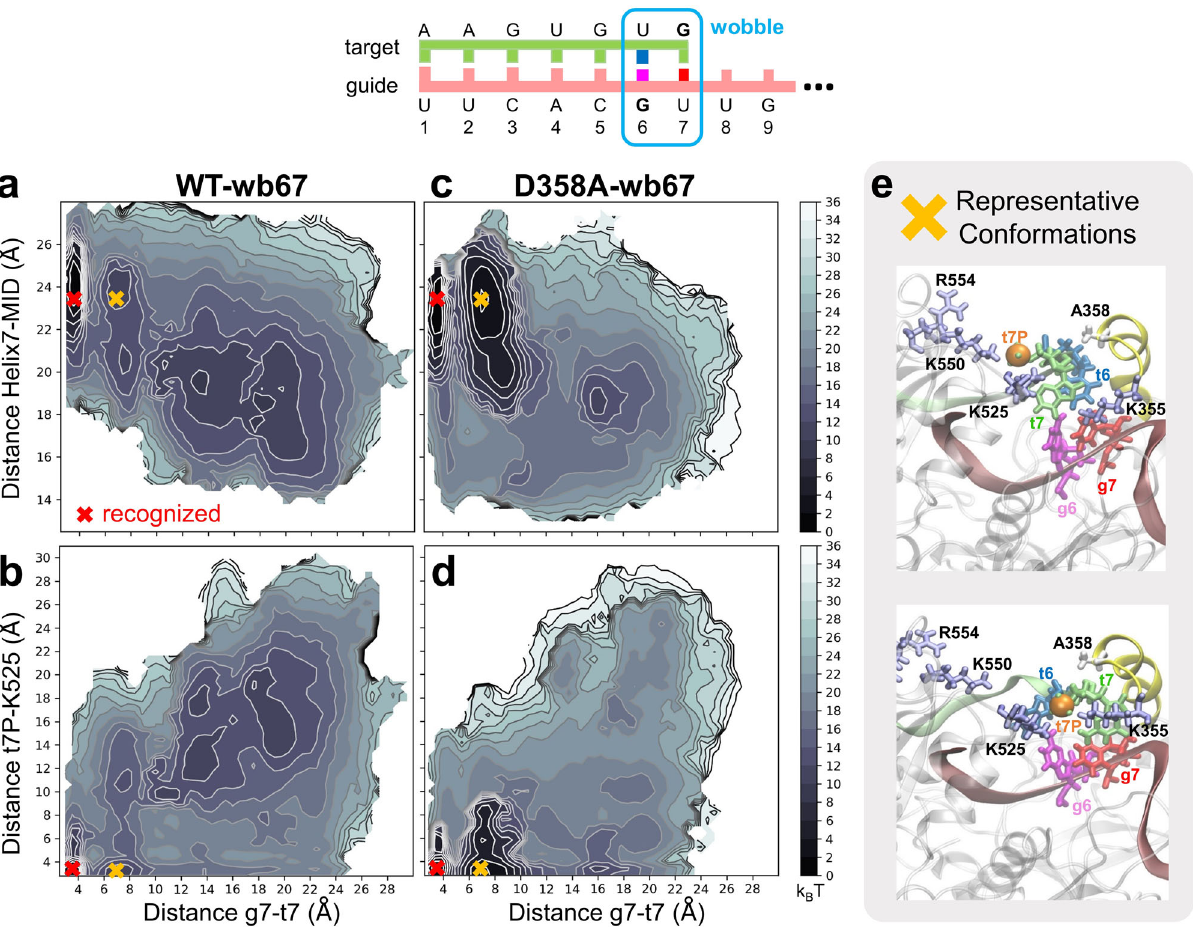
Fig. 5 Metadynamics simulations of the wild type and mutant D358A protein with two UG wobble pair at g6 and g7. a – d Reweighted free energy landscape of the g7-t7 distance, the distance between MID and Helix-7, and the distance between t7-phosphate and K525 are presented by contour plots. e Structures on the right are representative conformations for the D358A mutant extracted from the orange cross on the contour plots. The t7-phosphate (orange sphere), the positively charged residues (ice-blue), Helix-7 (yellow) and the A358 (white) are